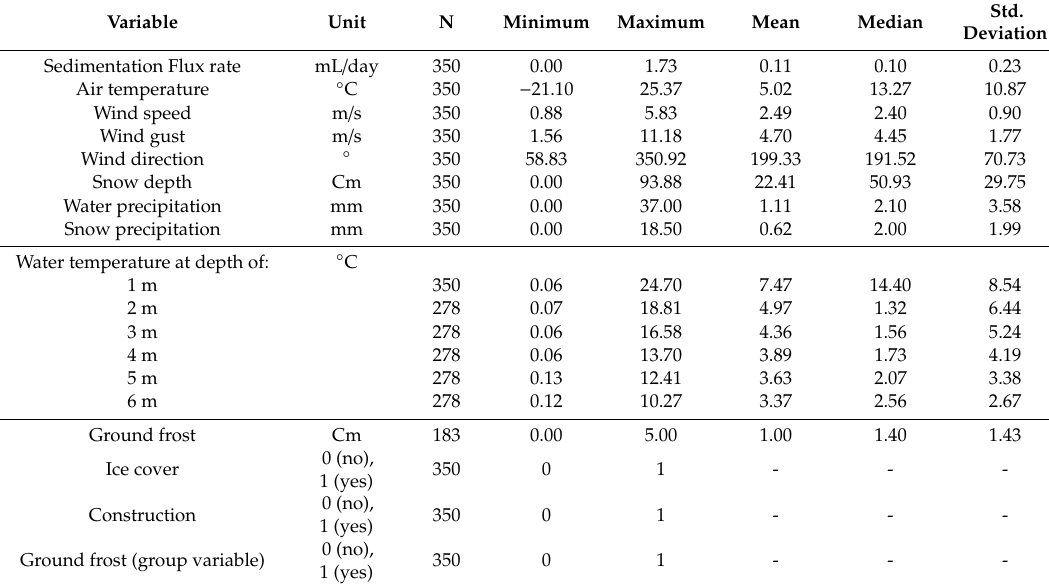
Table 2. Descriptive statistics of variables used in